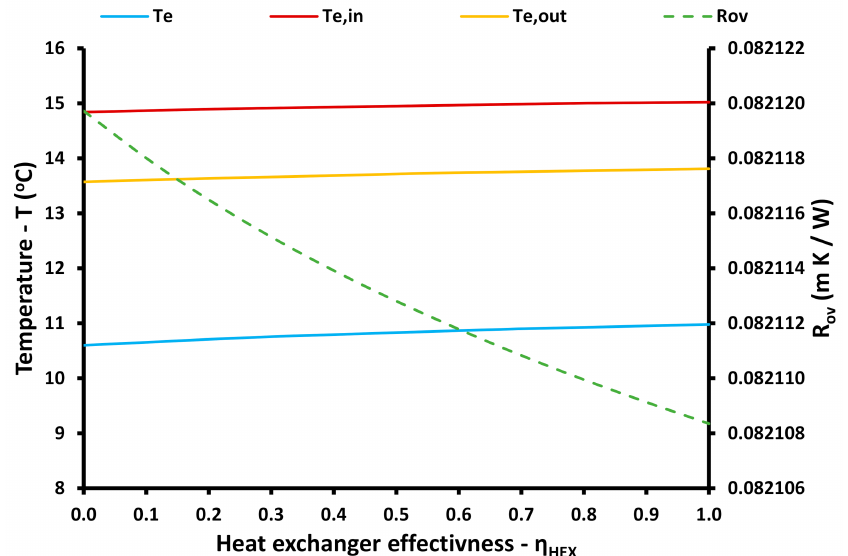
Figure 7. The impact of the heat exchanger effectiveness on the evaporator temperature levels and on the overall resistance.